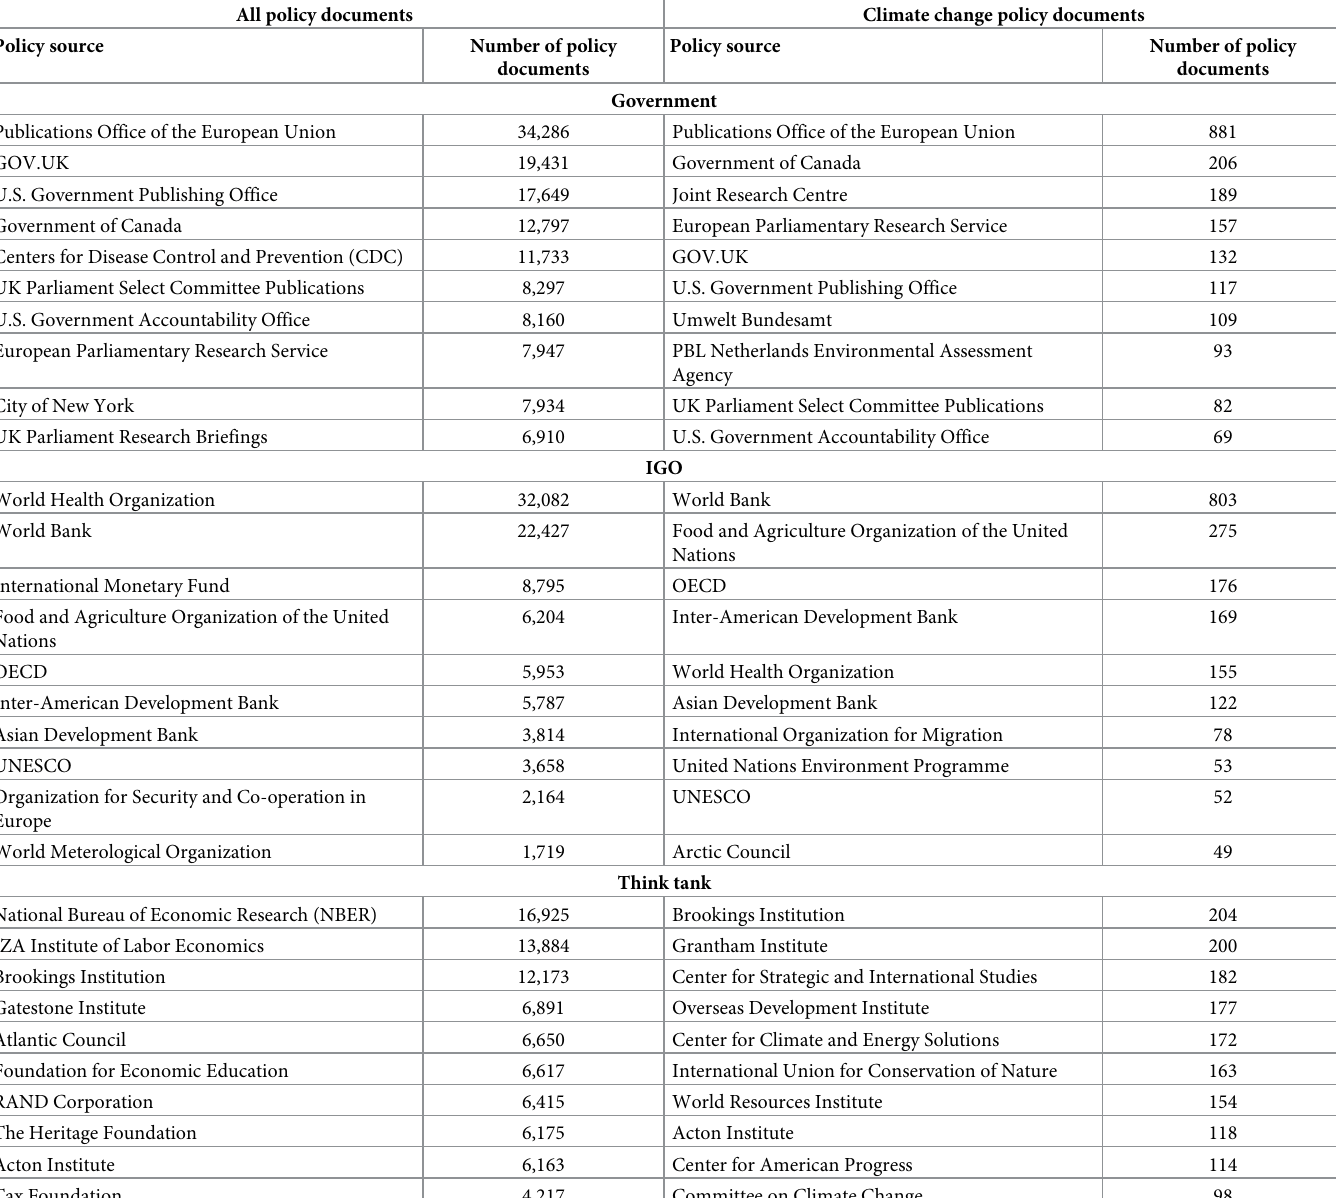
Table 3. Types of policy sources most productive in publishing policy documents citing papers related to climate change research. The table differentiates between all documents of the sources citing these papers and documents focussing on climate